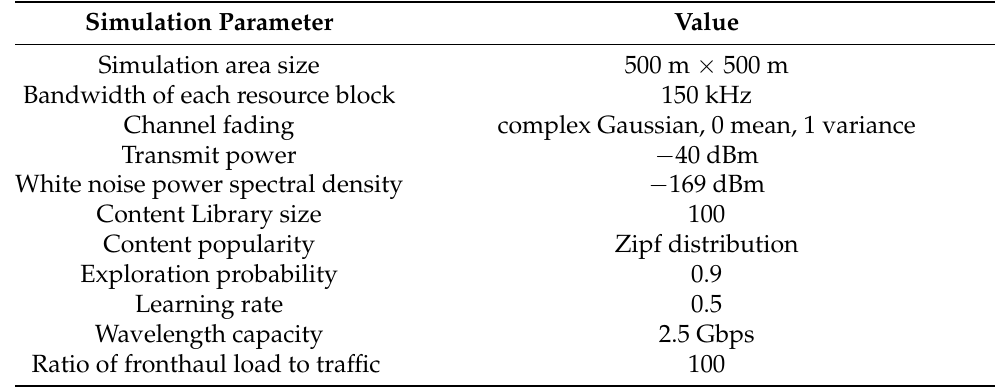
Table 1. Simulation